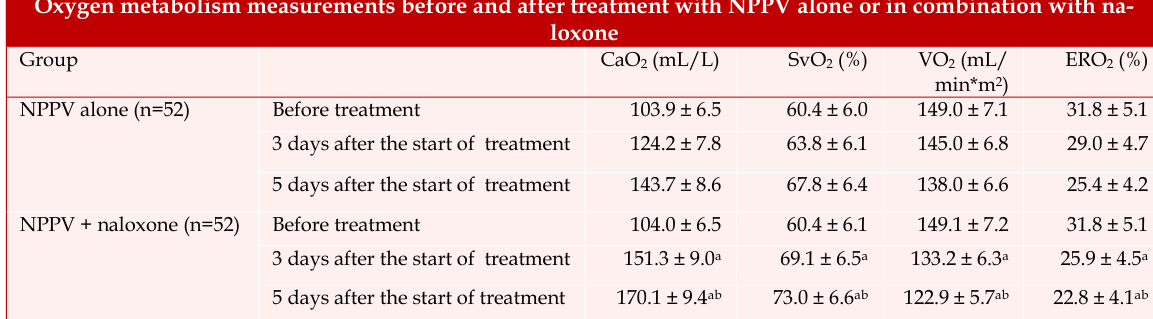
Oxygen metabolism measurements before and after treatment with NPPV alone or in combination with na-